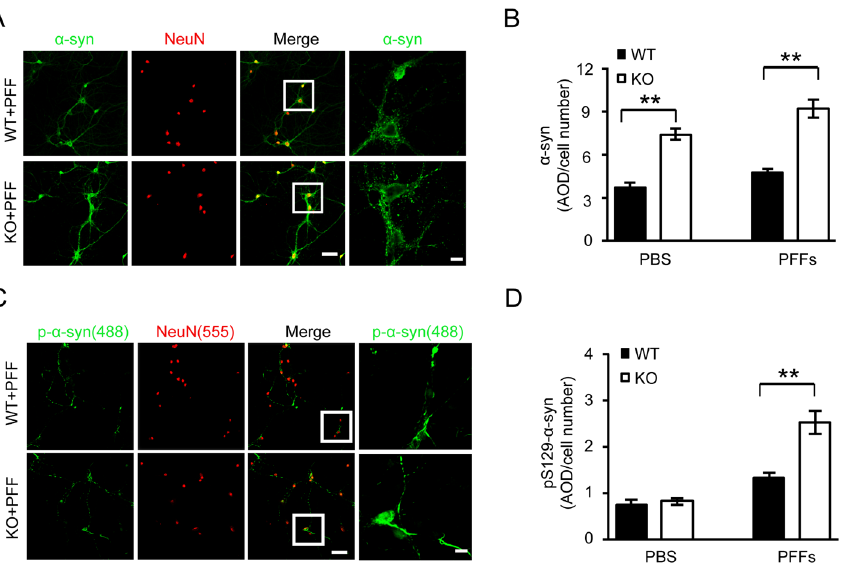
Figure 5. Thorase deficiency promotes α -syn aggregation in primary cultured neurons. ( A ) Im- munofluorescence visualization of PFF-induced endogenous mouse α -syn aggregate formation in WT and KO neurons. Neurons were fixed in 4% paraformaldehyde and 4% sucrose before immunoflu- orescence staining with an anti- α -syn antibody (BD, 1:1000) for endogenous mouse α -syn ( green ) aggregates and an antibody for the neuronal marker NeuN ( red ) antibody (Millipore, 1:1000). White rectangles represent for the corresponding right images of high magnification. Scale bars, 50 μ m. ( B ) Quantification of endogenous mouse total α -syn aggregates in WT and KO neurons shown in panel ( A ). ( C ) Immunofluorescence visualization of PFF-induced pS129- α -syn aggregate formation in WT and KO neurons with a pSyn#64 antibody (Wako, 1:1000) for pS129- α -syn (green) and an anti-NeuN (red) antibody (Millipore, 1:1000). White rectangles represent for the corresponding right images of high magnification. Scale bars, 50 μ m. ( D ) Quantification of the immunofluorescence sig- nal for pS129- α -syn aggregates in WT and KO neurons shown in panel ( C ). Data are presented as the mean ± SEM, determined by unpaired two-tailed Student’s t-test. ** p < 0.01. To investigate α -syn recruitment to pathologic inclusions, as demonstrated by exten- sive phosphorylation at Ser129 (pS129- α -syn) [27], we used pSyn#64 monoclonal antibod- ies specific for pS129- α -syn and found that pS129- α -syn-positive neuritic and perikaryal inclusions were significantly increased in PFF-treated Thorase KO neurons compared to WT neurons (Figure 5C,D). These results further indicate an increased formation of path- ologic α -syn aggregates in Thorase KO neurons. 3.6. Thorase Overexpression Prevents α -Synucleinopathy in PD Mouse Model A53T Mice To validate whether Thorase overexpression attenuates α -syn accumulation in vivo, A53T transgenic mice were crossed with inducible tetO-Thorase transgenic (cTg) mice to overexpress Thorase in the forebrains[6]. Immunohistochemical staining of brains from 9- month-old mice showed that pS129- α -syn accumulation was significantly lower in Thorase cTg-A53T mice than A53T mice (Figure 6A, B). Western blot analyses also showed that hSCNA and pS129- α -syn accumulation was significantly reduced in Thorase cTg- A53T mouse brain lysates compared to that in A53T mouse brain lysates (Figure 6C,D). We also discovered that Thorase overexpression significantly prevented the accumulation of the PD-associated insoluble α -syn and pS129- α -syn fractions; soluble α -syn levels dropped only slightly but showed no significant differences (Figure 6E,F). Together, these findings reveal that Thorase overexpression attenuates α -syn accumulation in vivo.